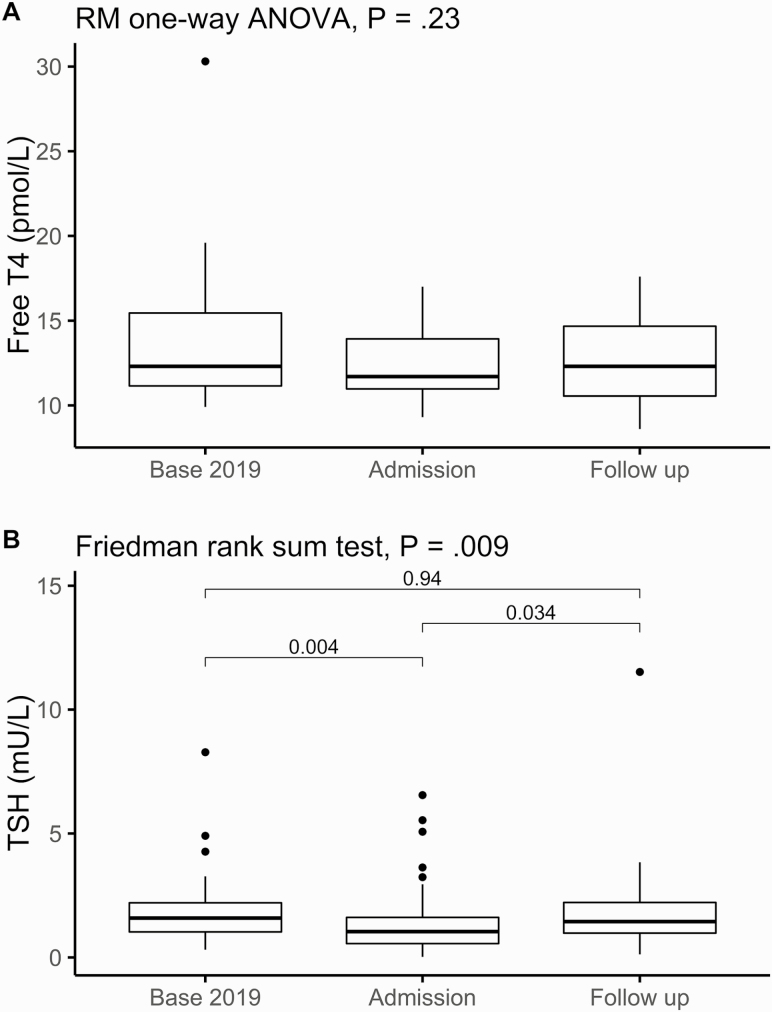
Longitudinal study of thyrotropin (TSH) and free thyroxine (T4) using 2019 baseline, admission, and follow up measurements. A (n = 20), free T4, and B (n = 50), TSH measurements, are plotted against the time point at which they were taken (baseline in 2019, admission with coronavirus disease 2019 (COVID-19), and follow-up). Repeated-measures one-way analysis of variance or Friedman rank sum test performed as indicated. Pairwise comparisons of TSH were performed with paired Wilcoxon signed-rank tests, with Bonferroni adjustment.